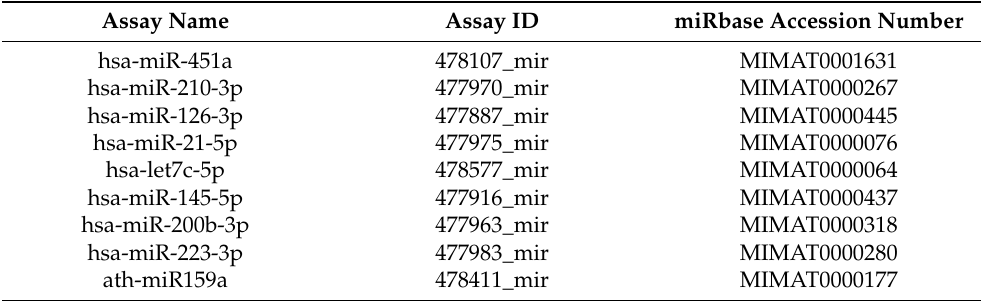
Table 1. MicroRNA assays used for the quantitative analyses of the target genes using real-time PCR. Assay Name Assay ID miRbase Accession Number hsa-miR-451a